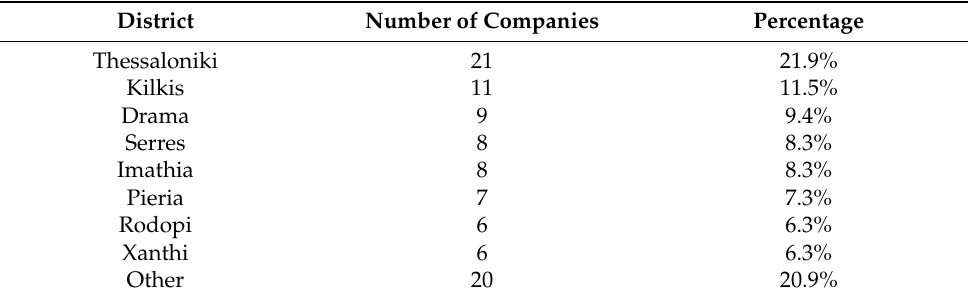
Table 1. Profile of the companies: District they facilitate.